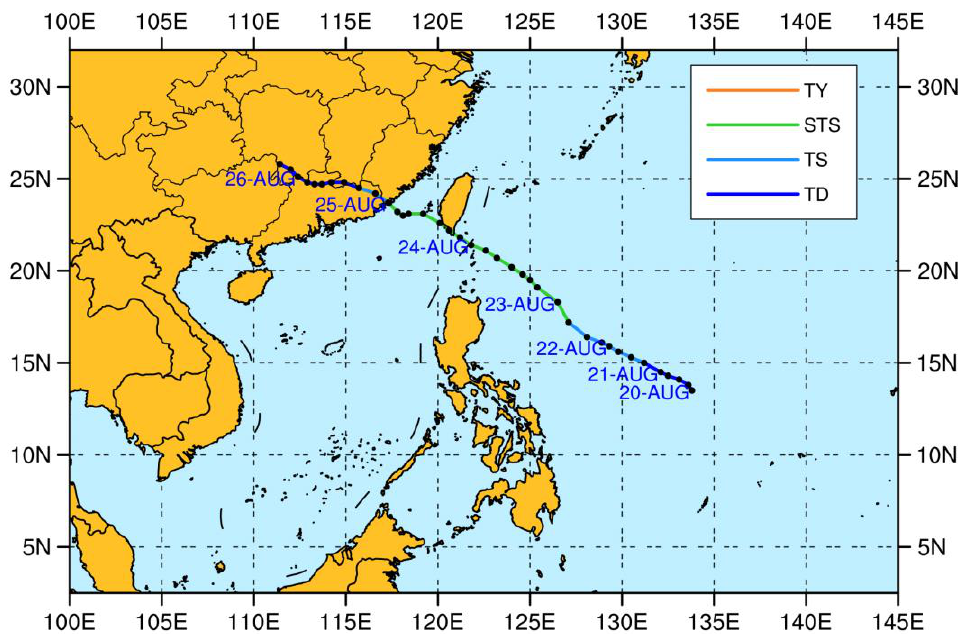
Figure 7. Track of Typhoon Bailu between 20 August 2019 and 26 August 2019. TD, tropical depression; TS, tropical storm; STS, severe tropical storm; TY, typhoon. The accumulated precipitation from 25 August 2019 at 00:00 to 27 August 2019 at